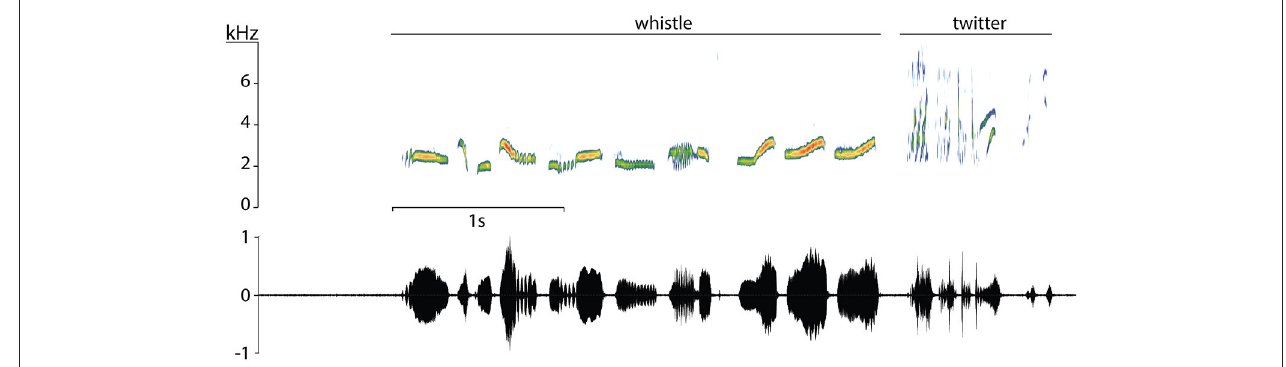
FIGURE 1 | Song of an European blackbird. In the spectrogram (Top) the motif and twitter notes are shown with their relative amplitude represented by differences in color (blue lowest, red highest). Below the spectrogram, the oscillogram of the same song shows the relative differences in